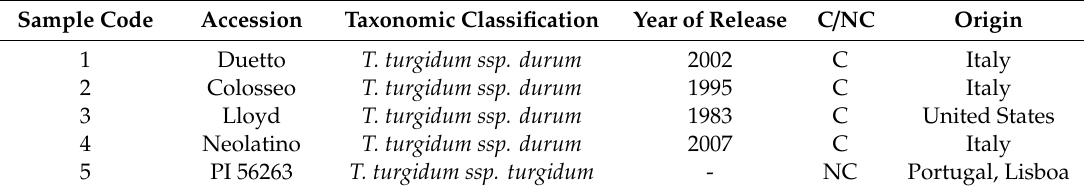
Table 1. Details of the selected wheat genotypes (C: cultivated, NC: